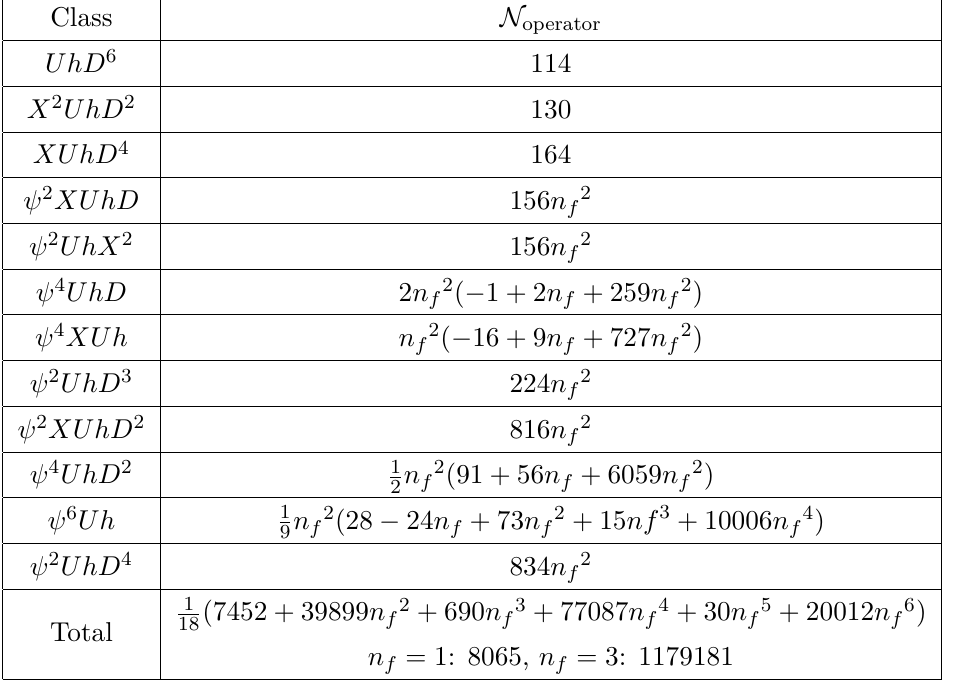
Because of the huge number of operators at NNLO, we can not make the explicit classification for all the types here, but all the operators without right-handed neu- trinos can be obtained in a similar way above in principle. For cross-check, we also present the Hilbert series result for the HEFT NNLO operators in the appendix and make a brief overview in table